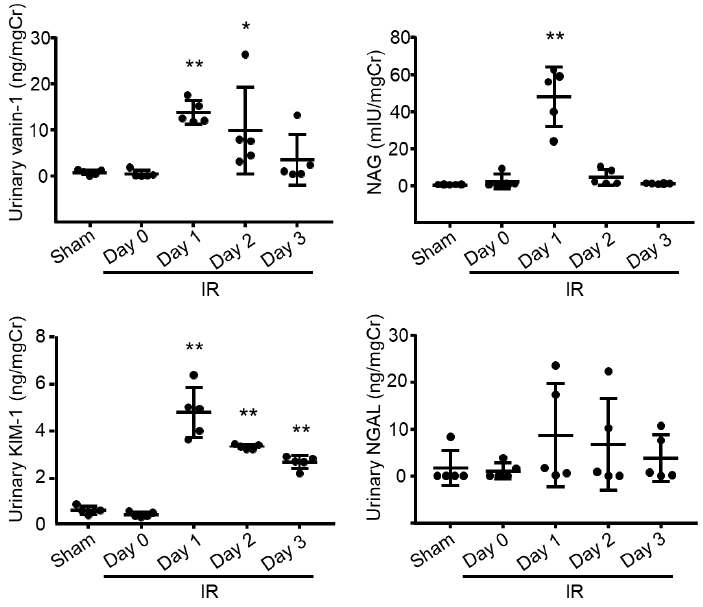
Figure 2. Evaluation of renal biomarkers. Concentrations of urinary vanin-1, NAG, KIM-1, and NGAL were normalized to the urinary creatinine concentration. Sham-operated rats, n = 6; I/R- treated rats, n = 5. * p < 0.05; ** p < 0.01 vs. sham-operated rats.